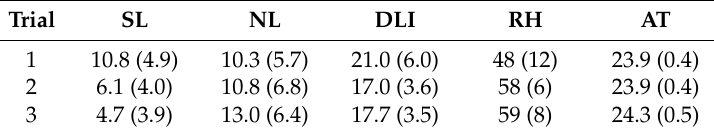
Table 4. Greenhouse conditions (mean and standard deviations (SD)) per trial for supplemental light (SL, moles/m 2 /day), natural light (NL, moles/m 2 /day), daily light integral (DLI, moles/m 2 /day), relative humidity (RH, %), and air temperature (AT, ◦ C). Trial SL NL DLI RH